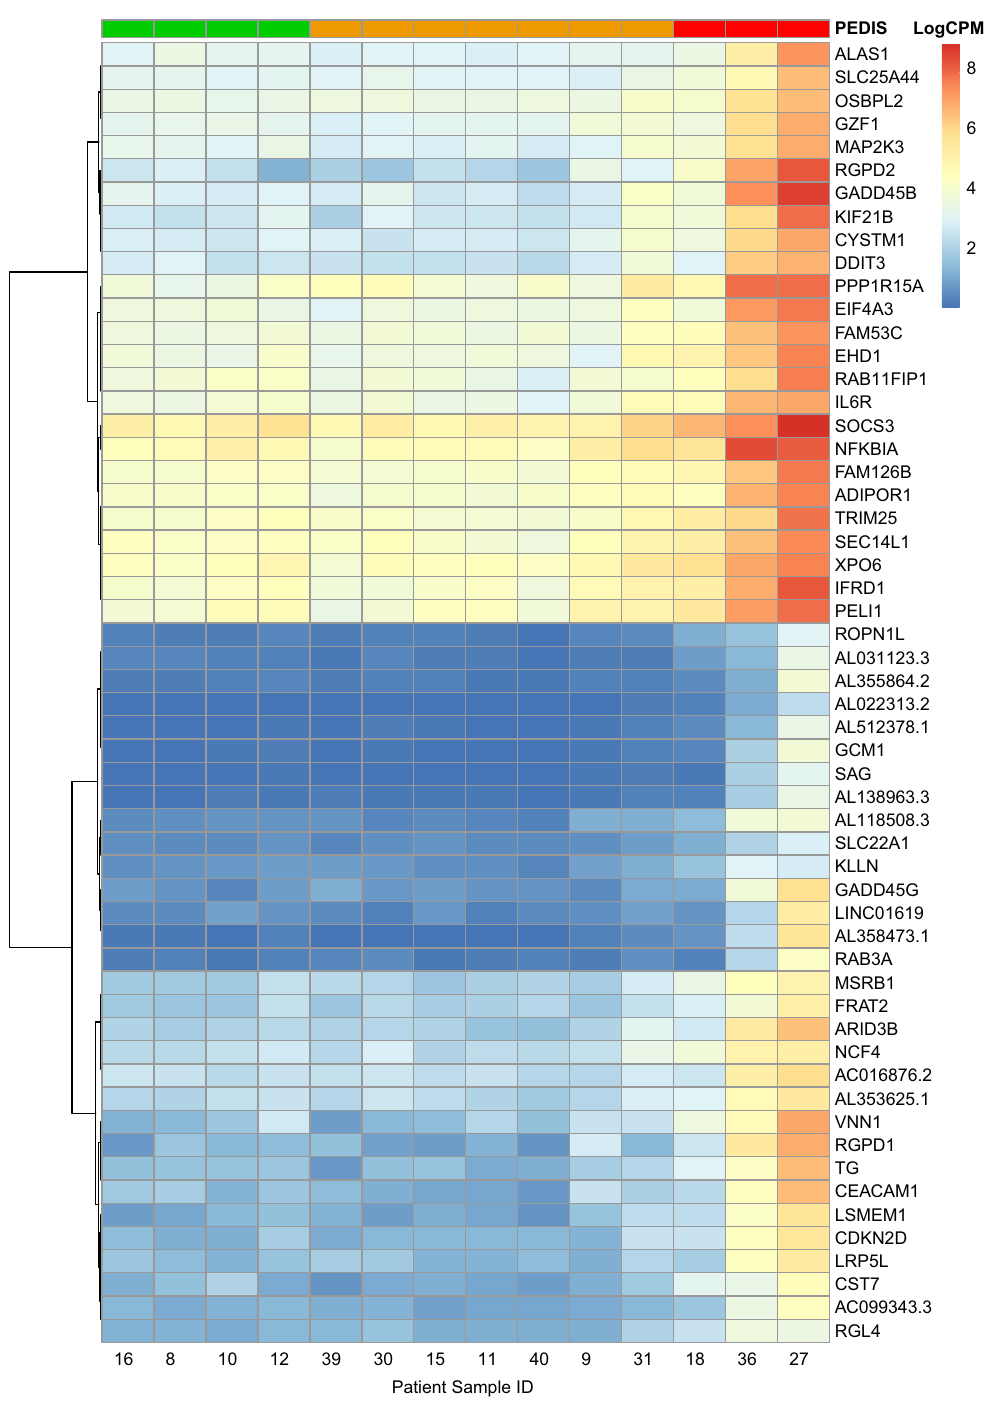
Fig. 4 Heat map of the top 50 most enriched host genes across all PEDIS infection severities. Read counts were normalized prior to applying a multi-level analysis (ANOVA) fi tting all contrasts between groups to identify the top 50 enriched genes. Patients are grouped by infection severity (PEDIS) with features clustered using Ward